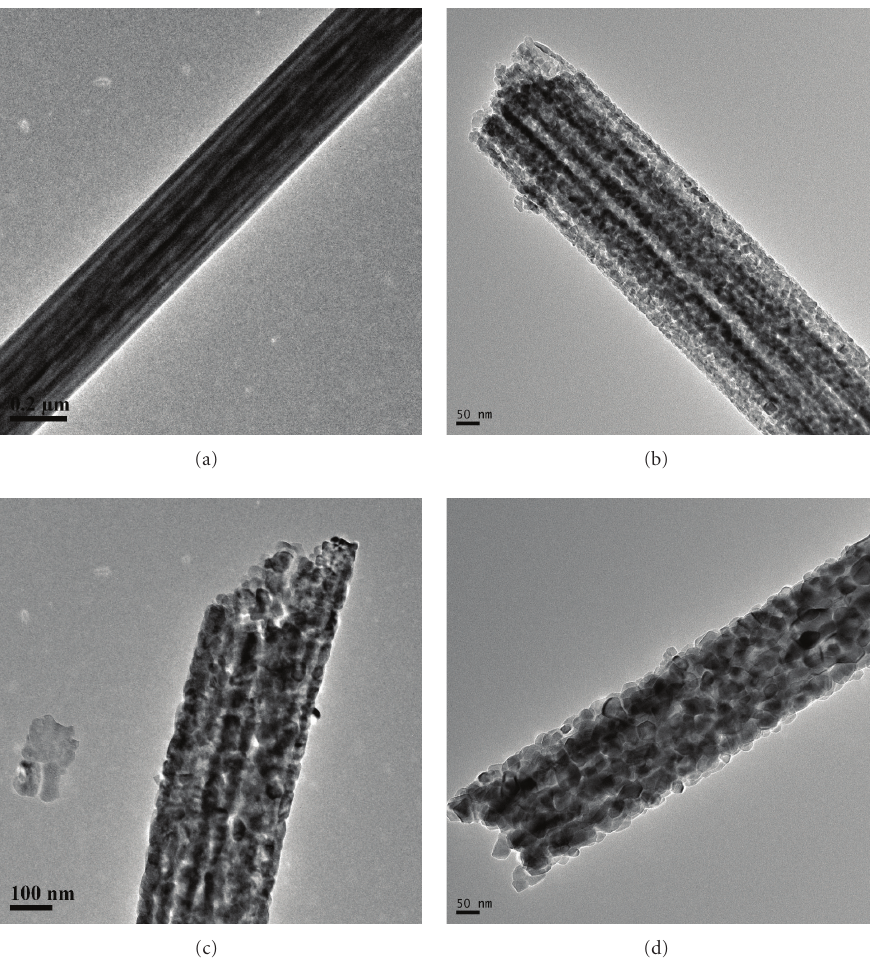
Figure 3: TEM images of (a) the PVP/TBT composite nanofibers and TiO 2 nanofibers obtained at (b) 500 ◦ C, (c) 600 ◦ C and (d) 700 ◦ C, respectively.